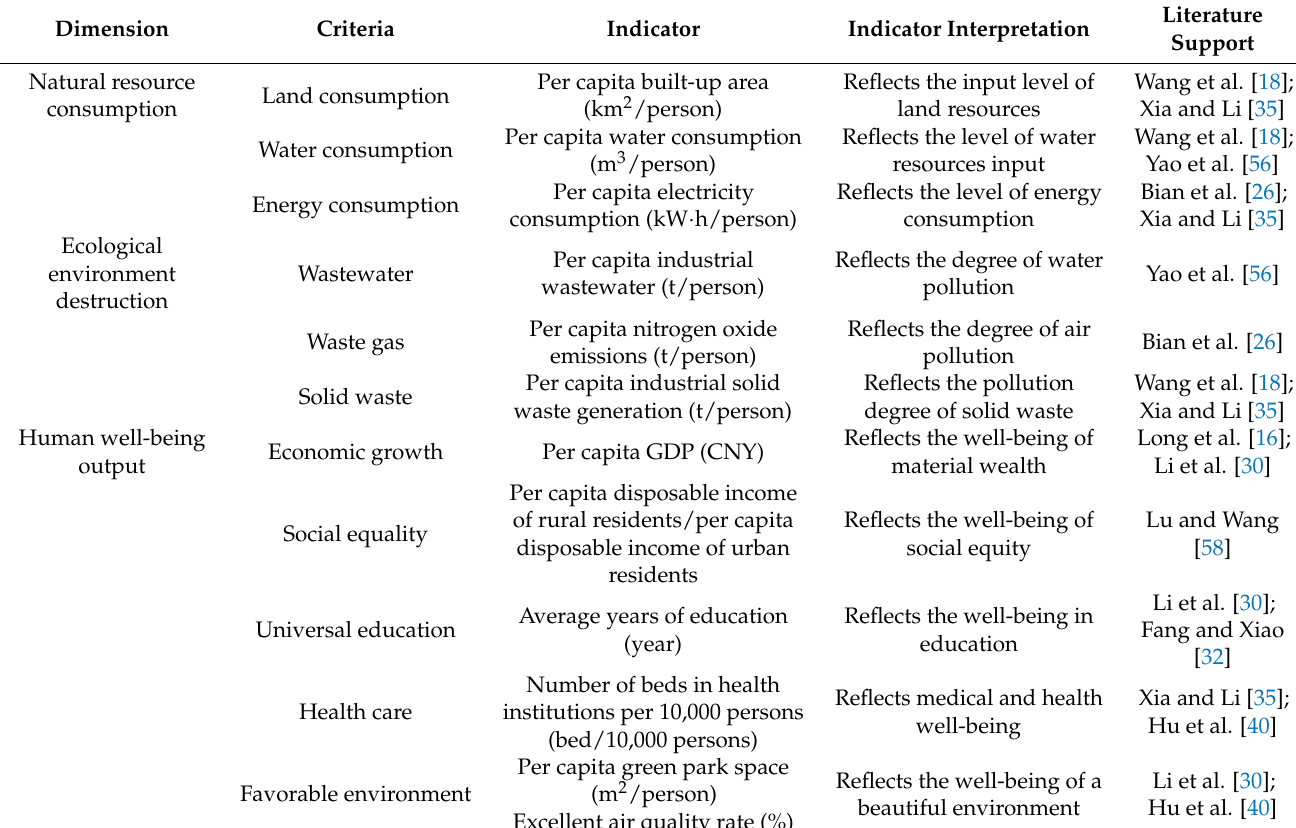
Table 1. Input–output evaluation index system of ecological well-being performance